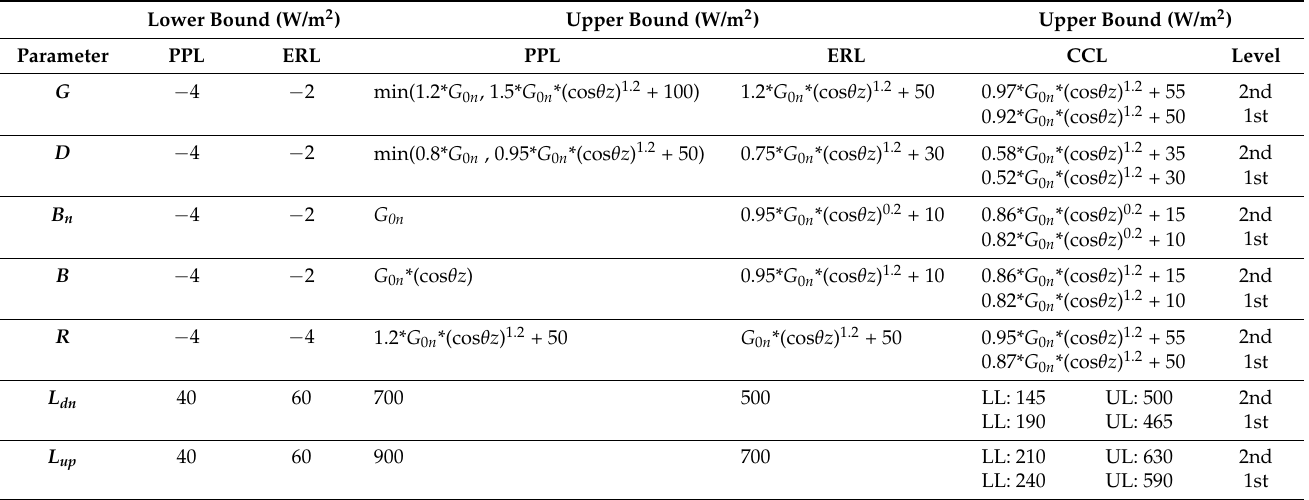
Table 3. BSRN-Physically Possible Limits (PPL), Extremely Rare Limits (ERL), and Configurable Climatological Limits (CCL) [27]. L dn and L up are the downward and upward longwave irradiances. Upper Bound (W/m 2